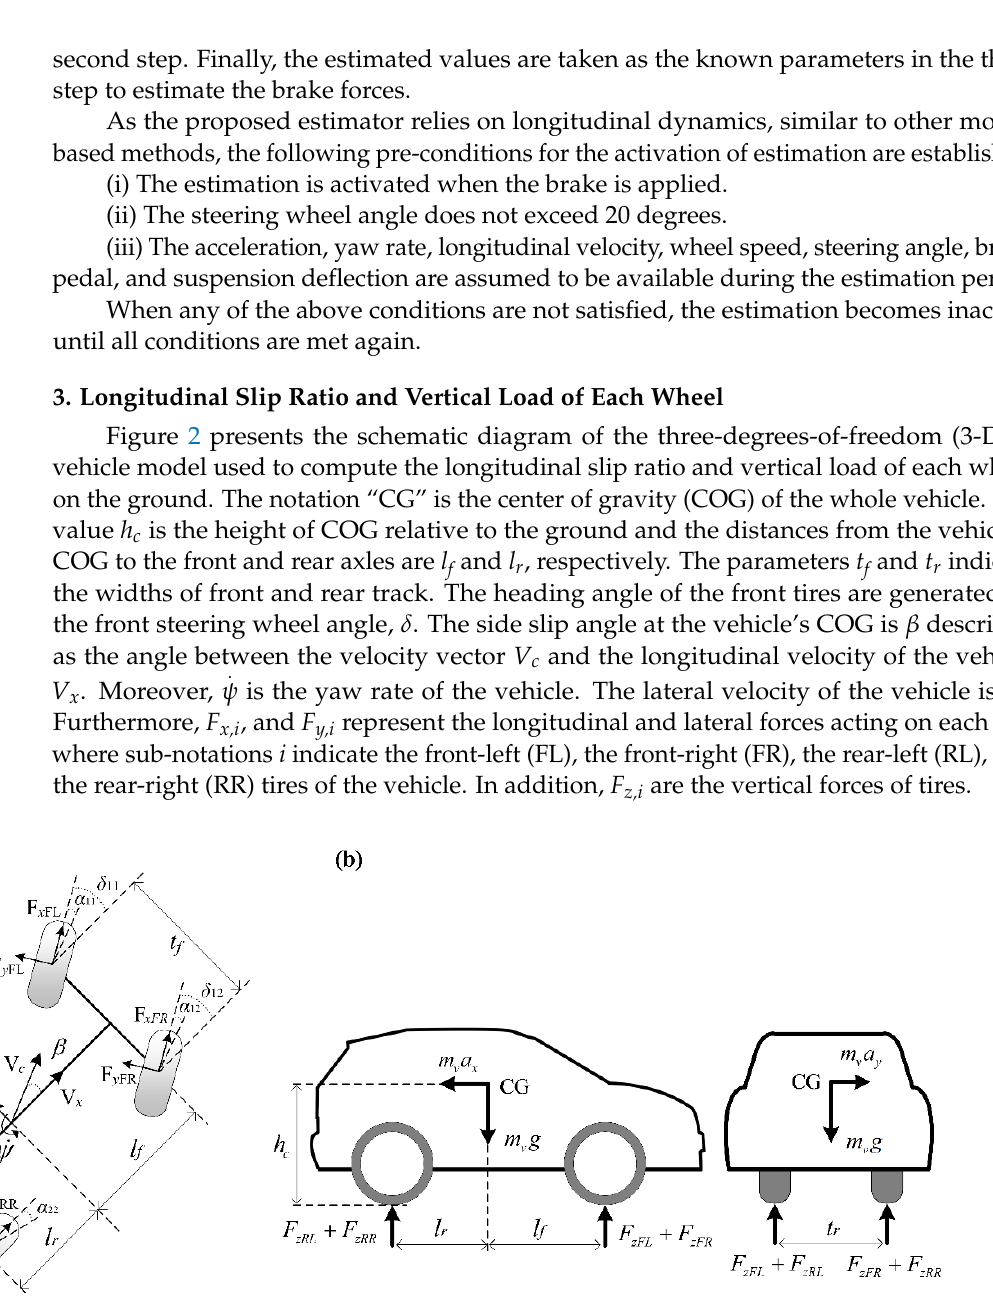
Figure 1. Entire structure of the proposed estimation systems.